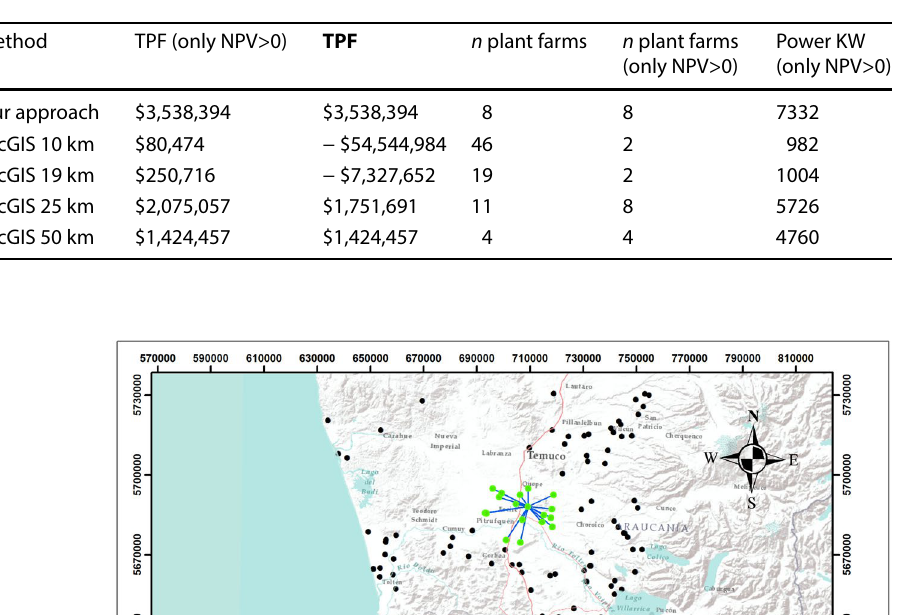
Table 2 Comparison of results on the most profitable scenario